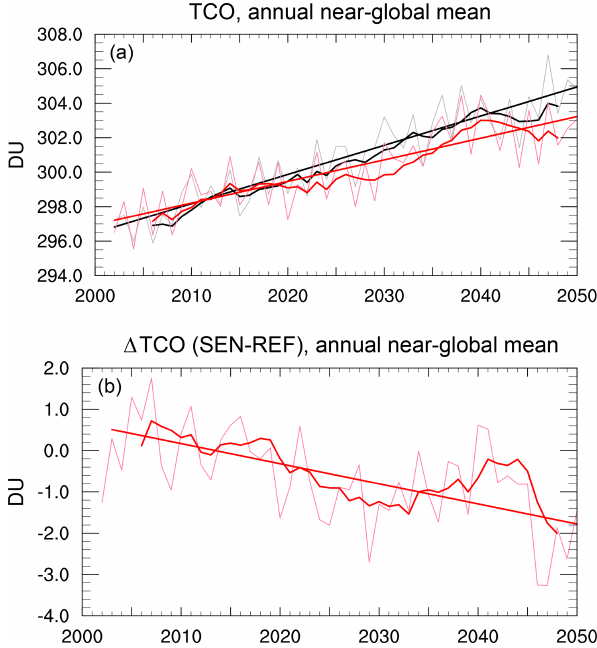
Figure 4. (a) Temporal evolution of total column ozone (TCO; in DU) for the annual near-global mean (60 ◦ S–60 ◦ N) in REF-C2 (black curves) and SEN-C2-fCFC11_2050 (red curves). (b) TCO differences (in DU) between SEN-C2-fCFC11_2050 and REF-C2 (i.e., SEN minus REF). For the absolute TCO time series (a) the 11- year solar cycle (smoothed with a 1-2-1 filter) has been removed. Thicker curves show the 5-year running means, respectively. The corresponding lines (a, b) show the respective linear regression es- timates based on the unsmoothed